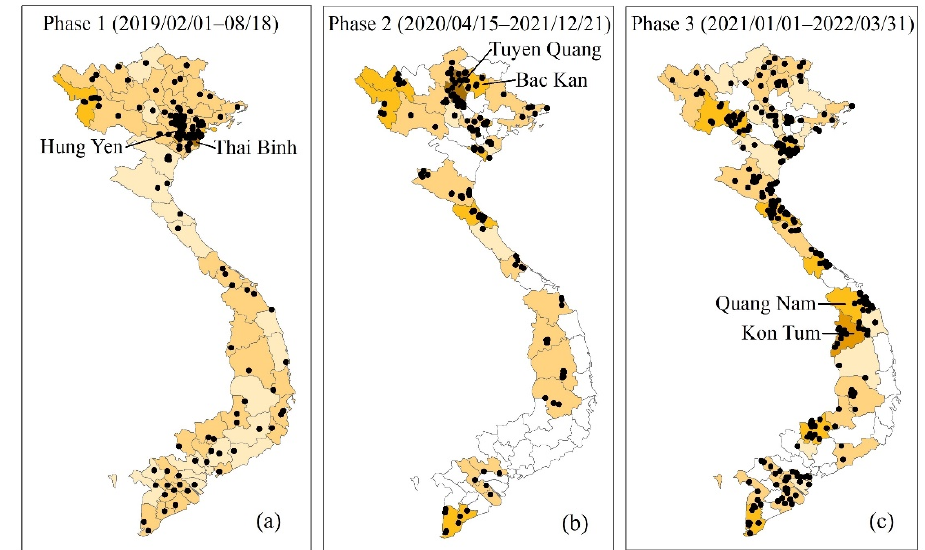
Figure 1. The number of new ASF outbreaks per month in Vietnam (February 2019–March 2022).